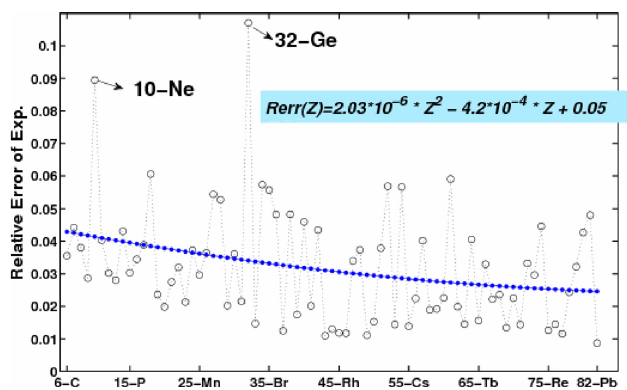
Fig. 5. The systematics study of the measured uncertainties of 12 C – 208 Pb(n,tot) cross